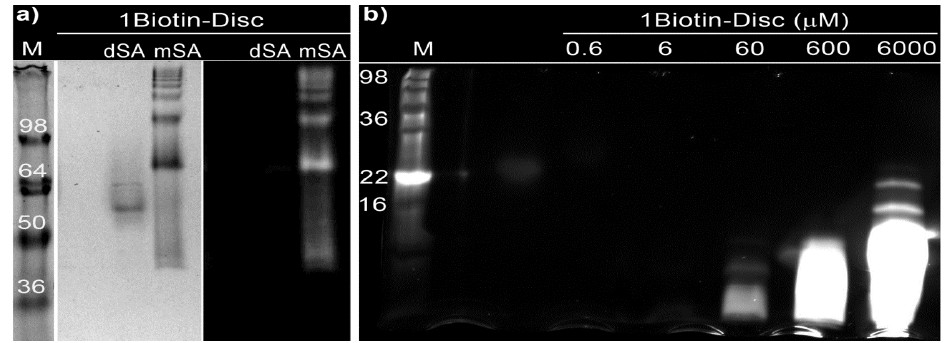
Figure 3. ( a ) Semi-native sodium dodecyl sulfate (SDS)-gel (8%) stained with Coomassie = 350 nm) before staining. Concentration blue ( left ) and under UV-illumination ( right , λ ex of 1Biotin-Disc is 20 µM, of dSA and mSA 0.4 mg/mL; ( b ) Semi-native SDS-gel (15%) under UV-illumination of different concentrations of the 1Biotin-Disc